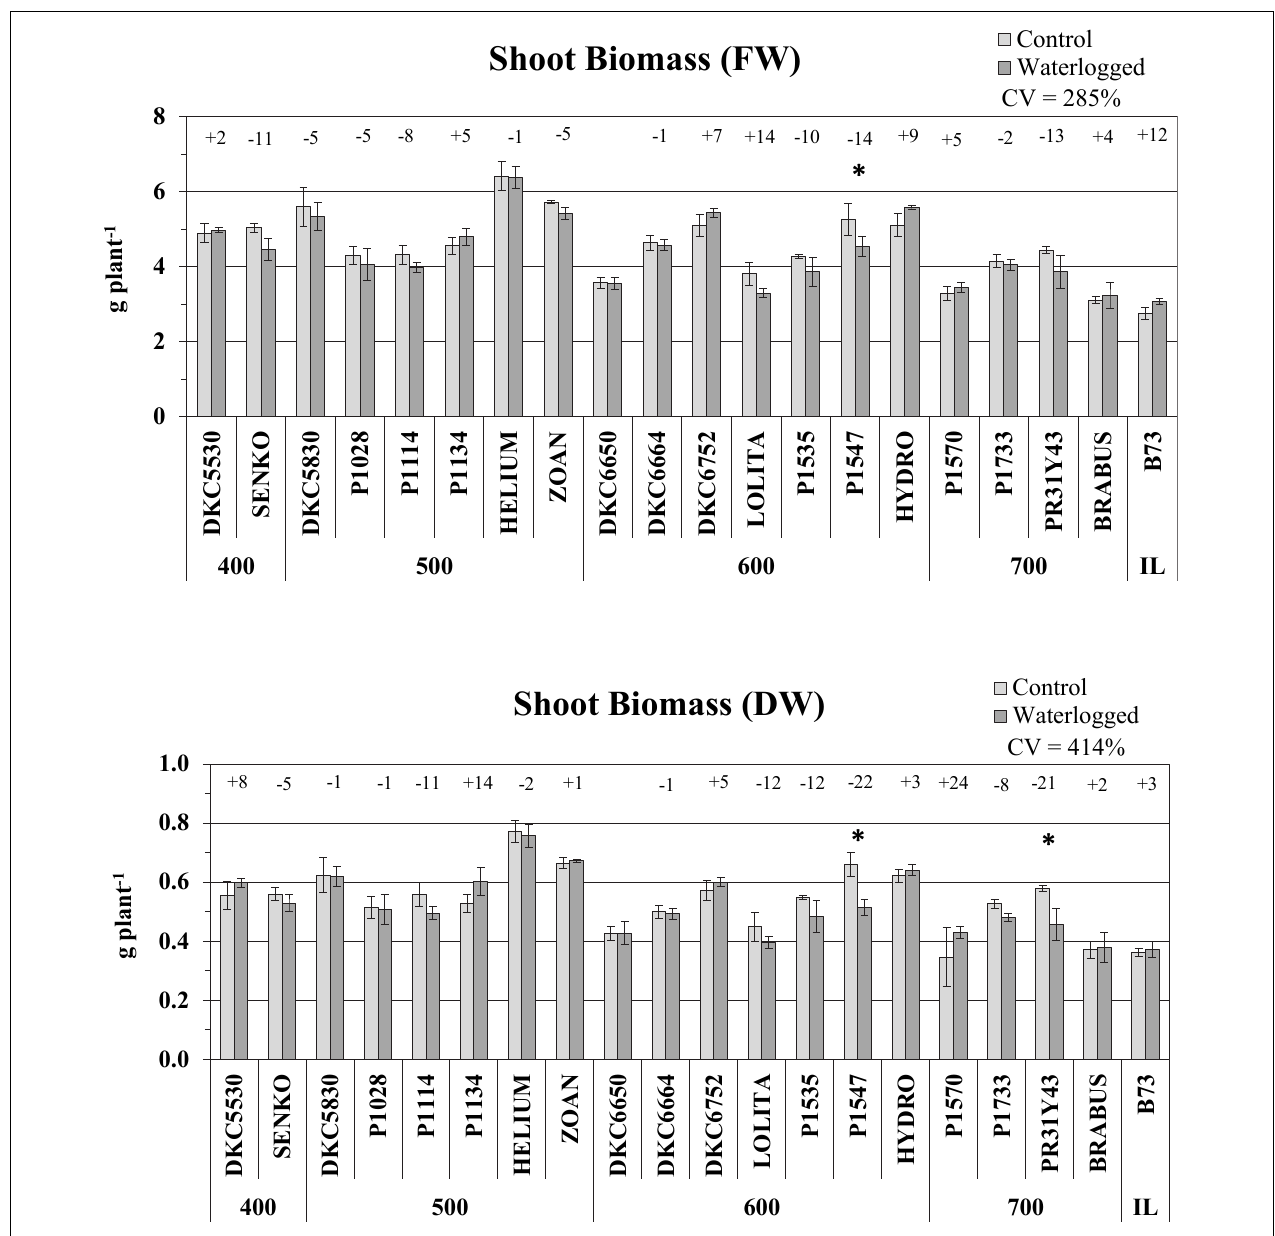
FIGURE 3 | Shoot fresh weight (FW) and dry weight (DW) (average ± SE; n = 3) of control and waterlogged plants of commercial hybrids and the inbred line B73 at 17 DAS, grouped according to FAO class of maturity (from 400 to 700). Numbers above histograms indicate the percentage variation between waterlogged plants and controls for each hybrid, with asterisks indicating significance ( P ≤